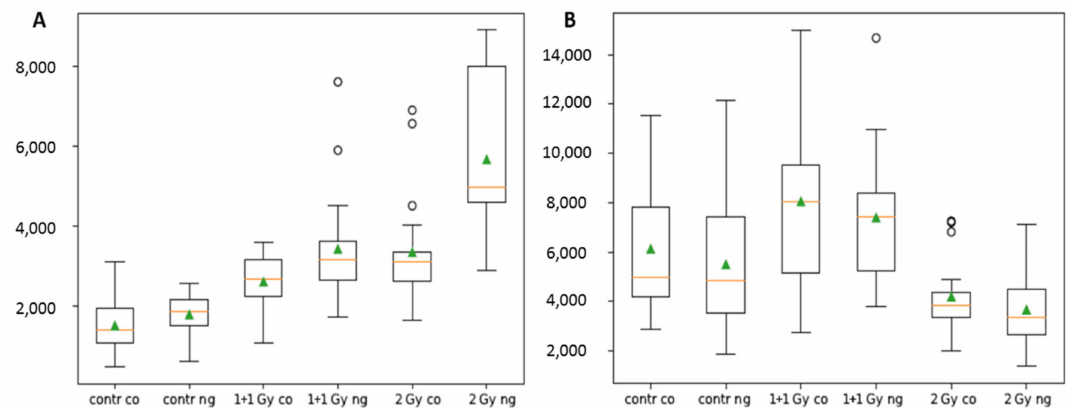
Figure 10. Absolute number of fluorescent points detected per image (z-section of 500 nm) for the different experiment; contr = non-irradiated control; 1 + 1 Gy = radiation scheme 1 G—30 min—1 Gy; ng = GNPs (nano-gold); co = control without GNPs. Each detected point represents a fluorescent antibody against the γ -H2AX molecule ( A ) or the H3K9 methylation site ( B ) as detected in an image plane of the cell nucleus. Blinking events within the localization precision of the specific image were registered as one point. The boxplots show the mean point number of the detected nuclei ( green triangle ), the median ( orange line ), the lower and upper quantile (box), and the value range within ± 2 standard deviations ( black line ). The black circles refer to values that are differing more than 1 box length from the